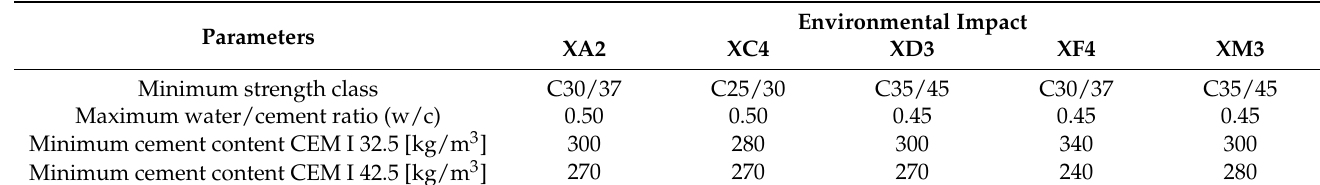
Table 1. Restrictions concerning the composition of concrete intended for airfield pavements.